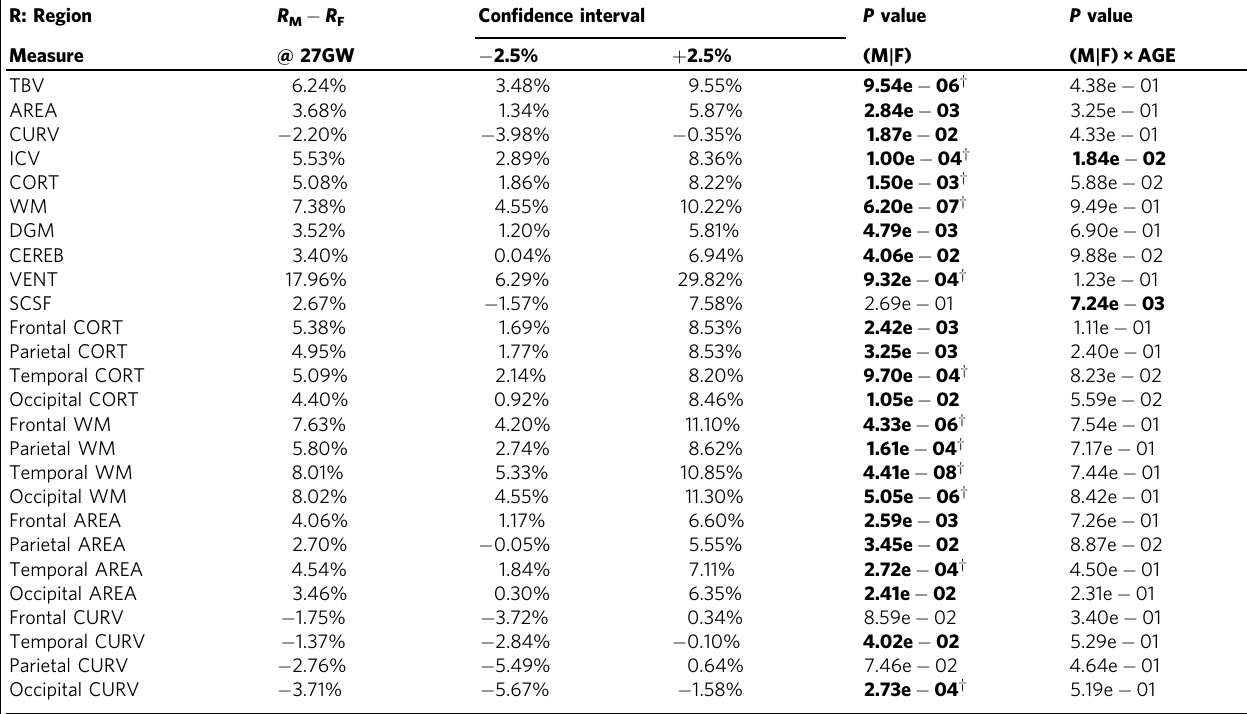
Table 1 Differences in absolute growth